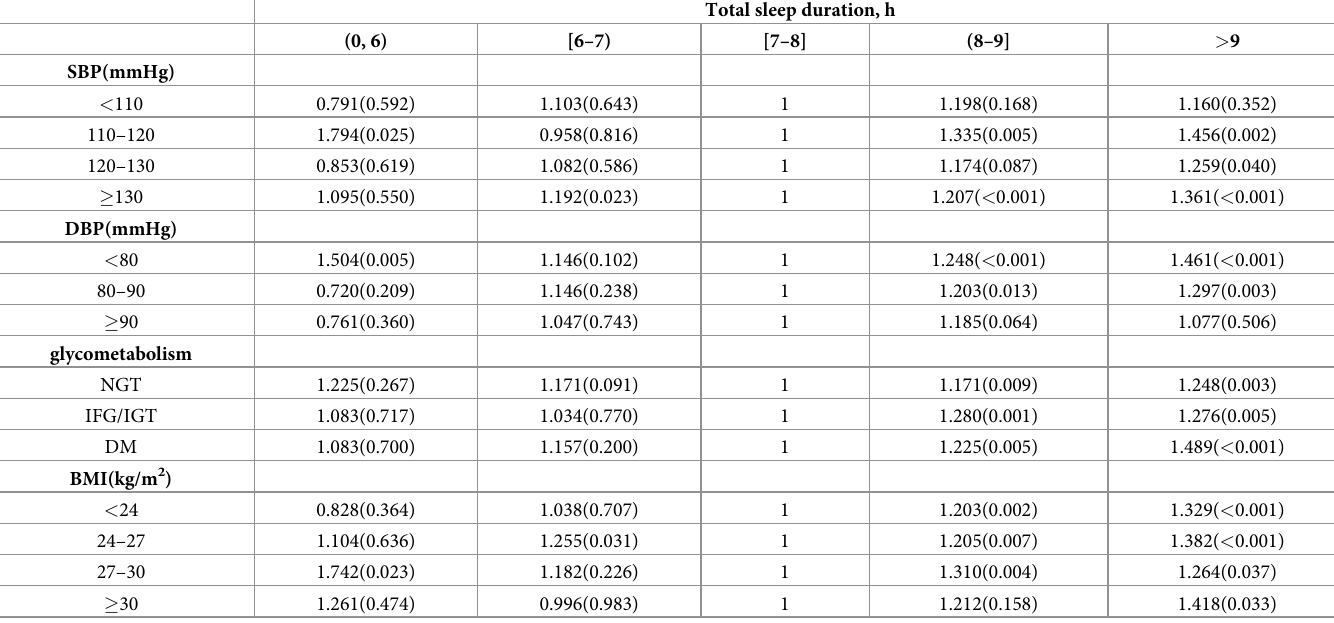
Table 5. Risk for microalbuminuria according to total sleep duration among diverse